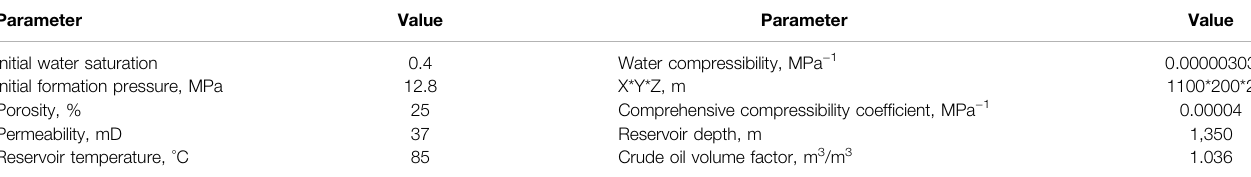
TABLE 2 | Basic parameters of the target block.